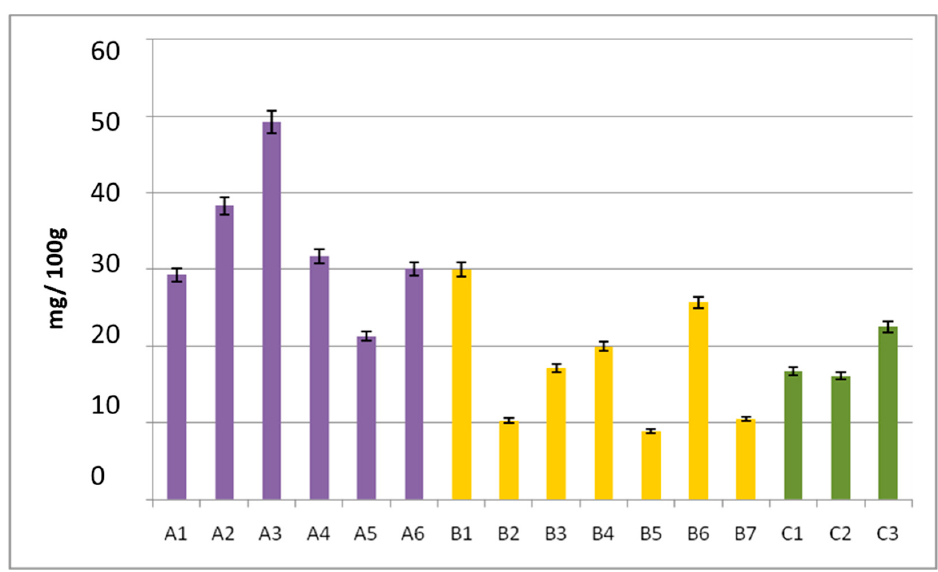
Figure 2. Box and whisker plots for the concentrations of Dlp; Cyn; Pt; Pn; Mlvin red grapes belong- ing to ‘Kotsifali’, ‘Limnio’, and ‘Vradiano’.